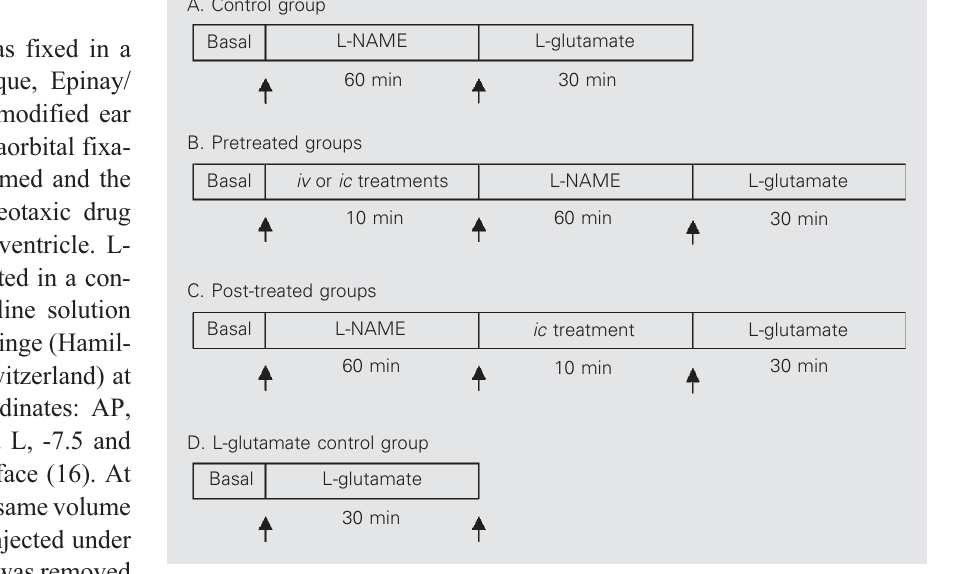
Figure 1. Schematic representation of the experimental protocols. L-NAME, N (cid:2) -nitro-L- arginine methyl ester; iv , intravenous; ic ,